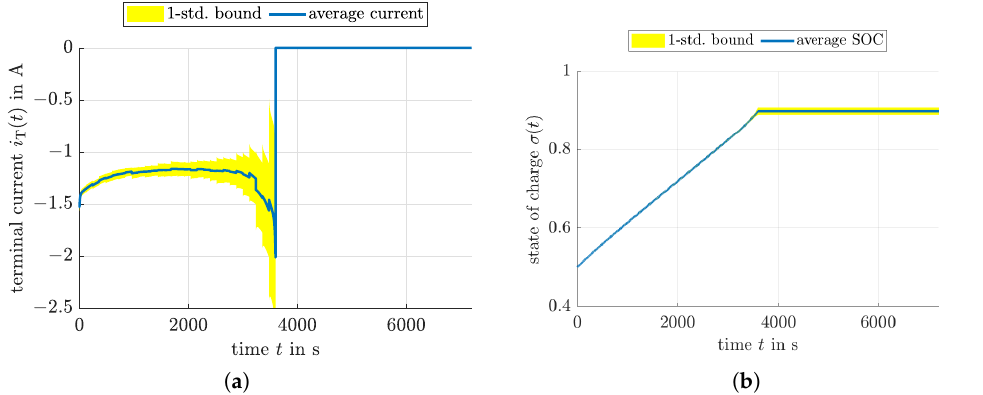
Figure 7. Model predictive control under the influence of state reconstruction noise. ( a ) Terminal current i T ( t ) for α = 0.01; ( b ) SOC σ ( t ) for α =